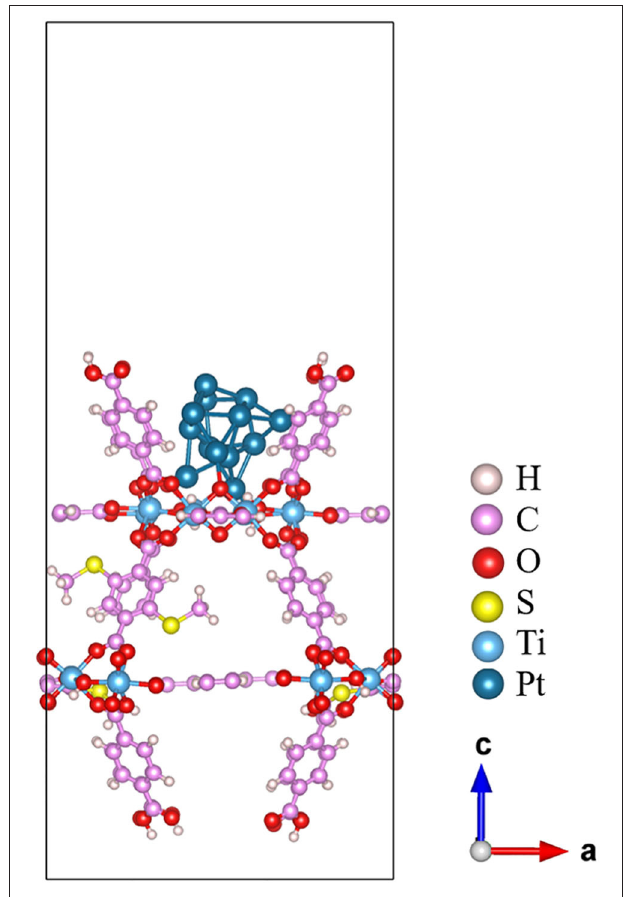
FIGURE 2 | The PBE optimized structure of Pt 13 /20%-MIL-125-(SCH 3 ) 2 (001) plane.